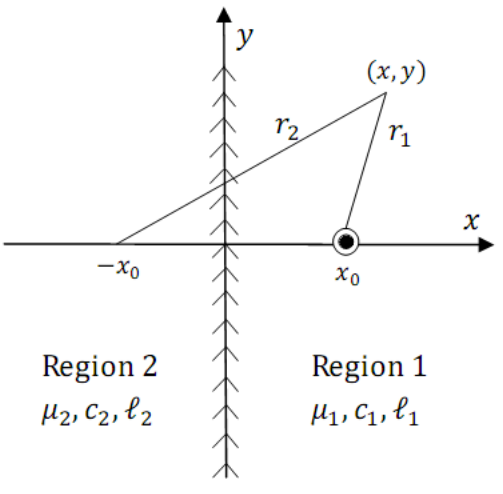
Figure 1: A screw dislocation near a bi-medium interface